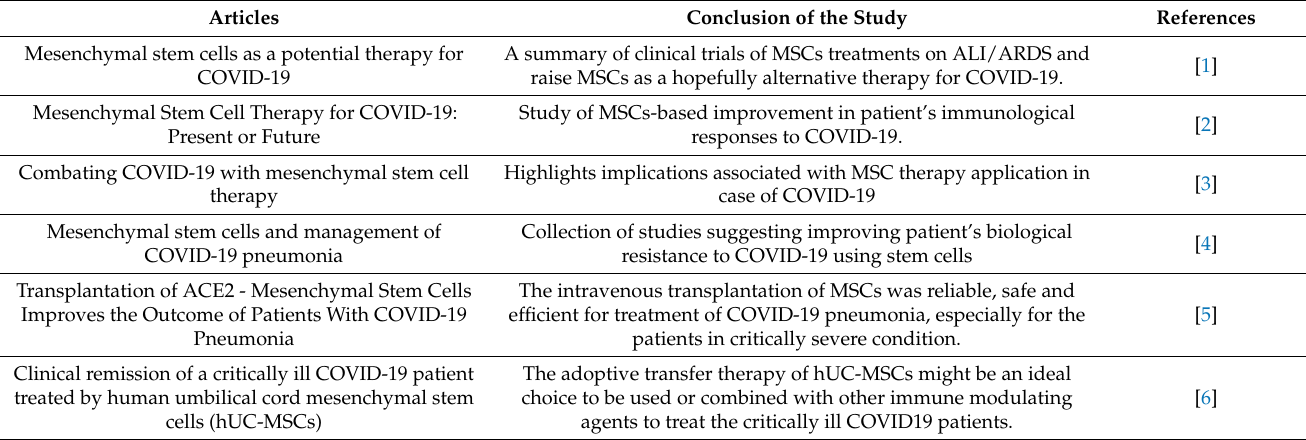
Table 2. Studies showing mesenchymal stem cells as therapy in